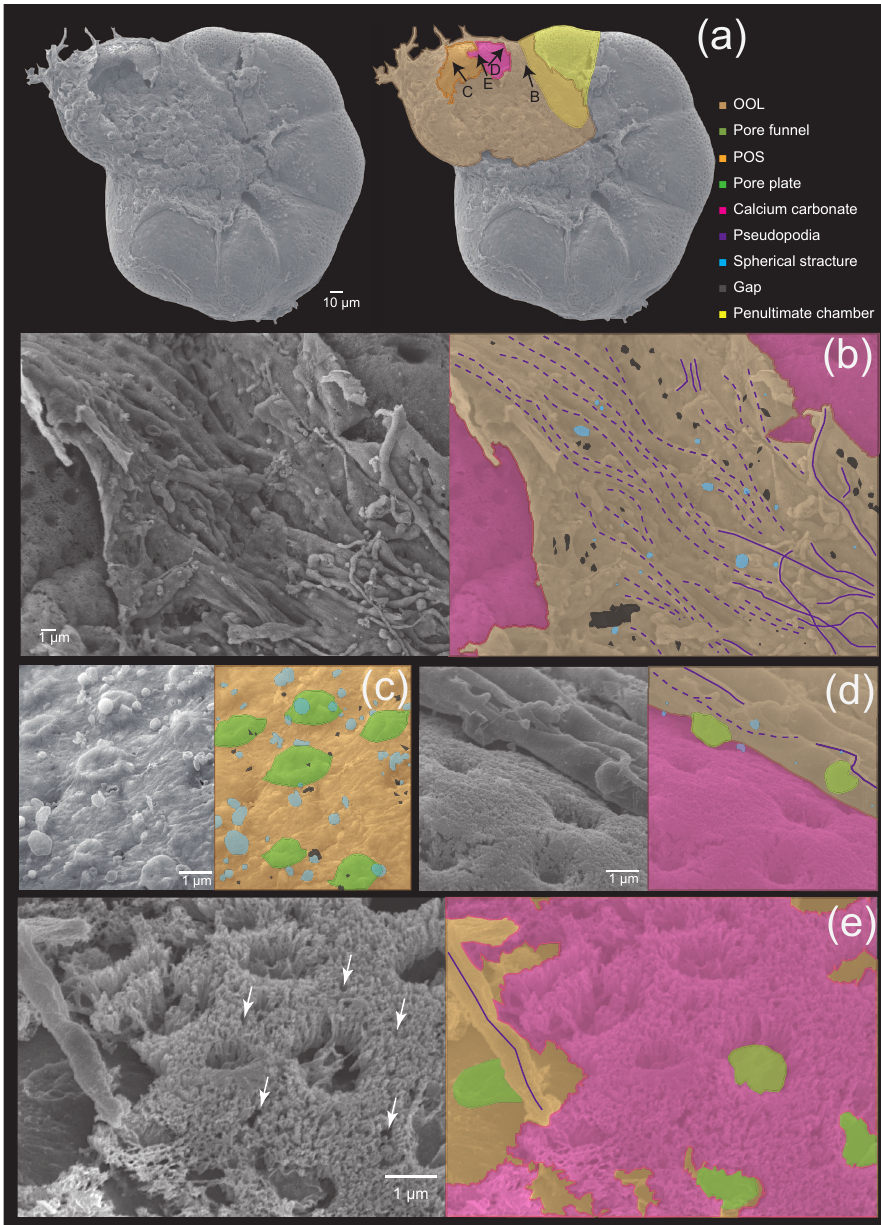
Figure 4. Microstructures during the middle stage of the chamber formation shown by SEM images on the left, supplemented by schematic explanation on the right. (a) Overview of the ventral side of a specimen, showing the cytoplasm covering the newly forming chamber. (b) Magnified image showing the OOL on the suture, between the new chamber and the previous chamber. (c) A higher magnification image of the POS showing spherical structures on the POS. (d) Image showing the matching relationship between convex structures on the cytoplasmic surface of the OOL and the pore. (e) Needle-like crystals of calcium carbonate between the IOL and the OOL, with white arrowheads indicating clear gaps between the crystals. Colour legend: brown = OOL; orange = POS; purple = pseudopodia/cytoplasm; light green = pore funnel on the OOL; green = pore plate; magenta = calcium carbonate; blue = spherical structures; gray = gap. Thick lines indicate membranous pseudopodia and dotted lines indicate framework